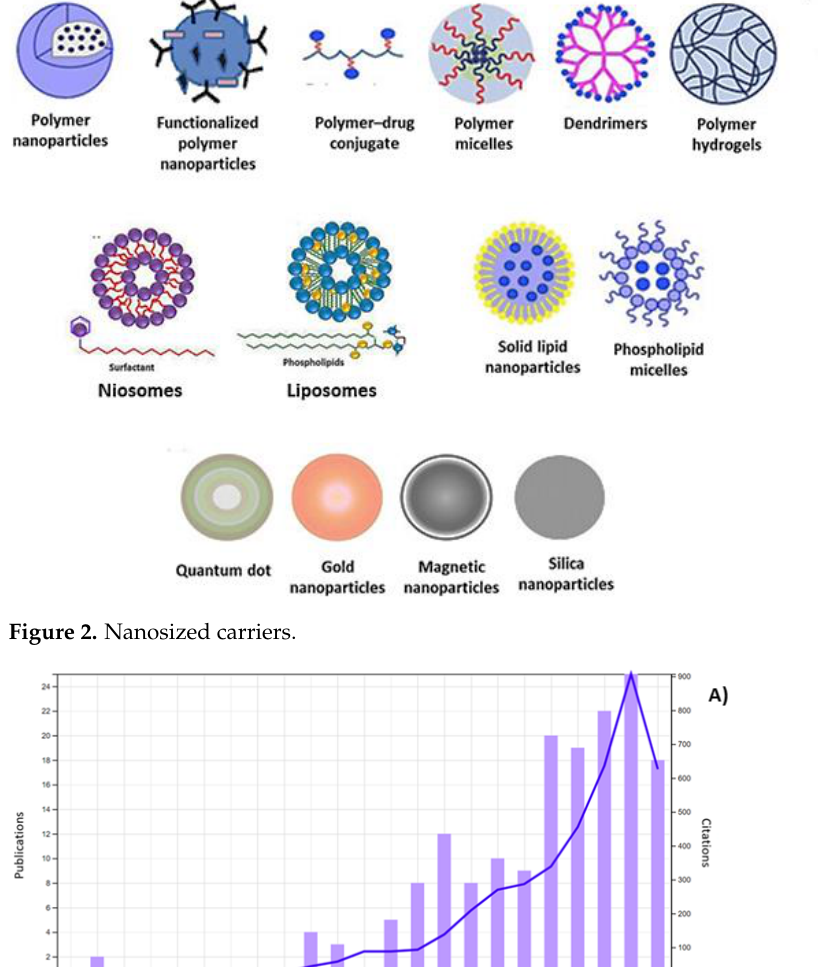
Figure 2. Nanosized carriers.